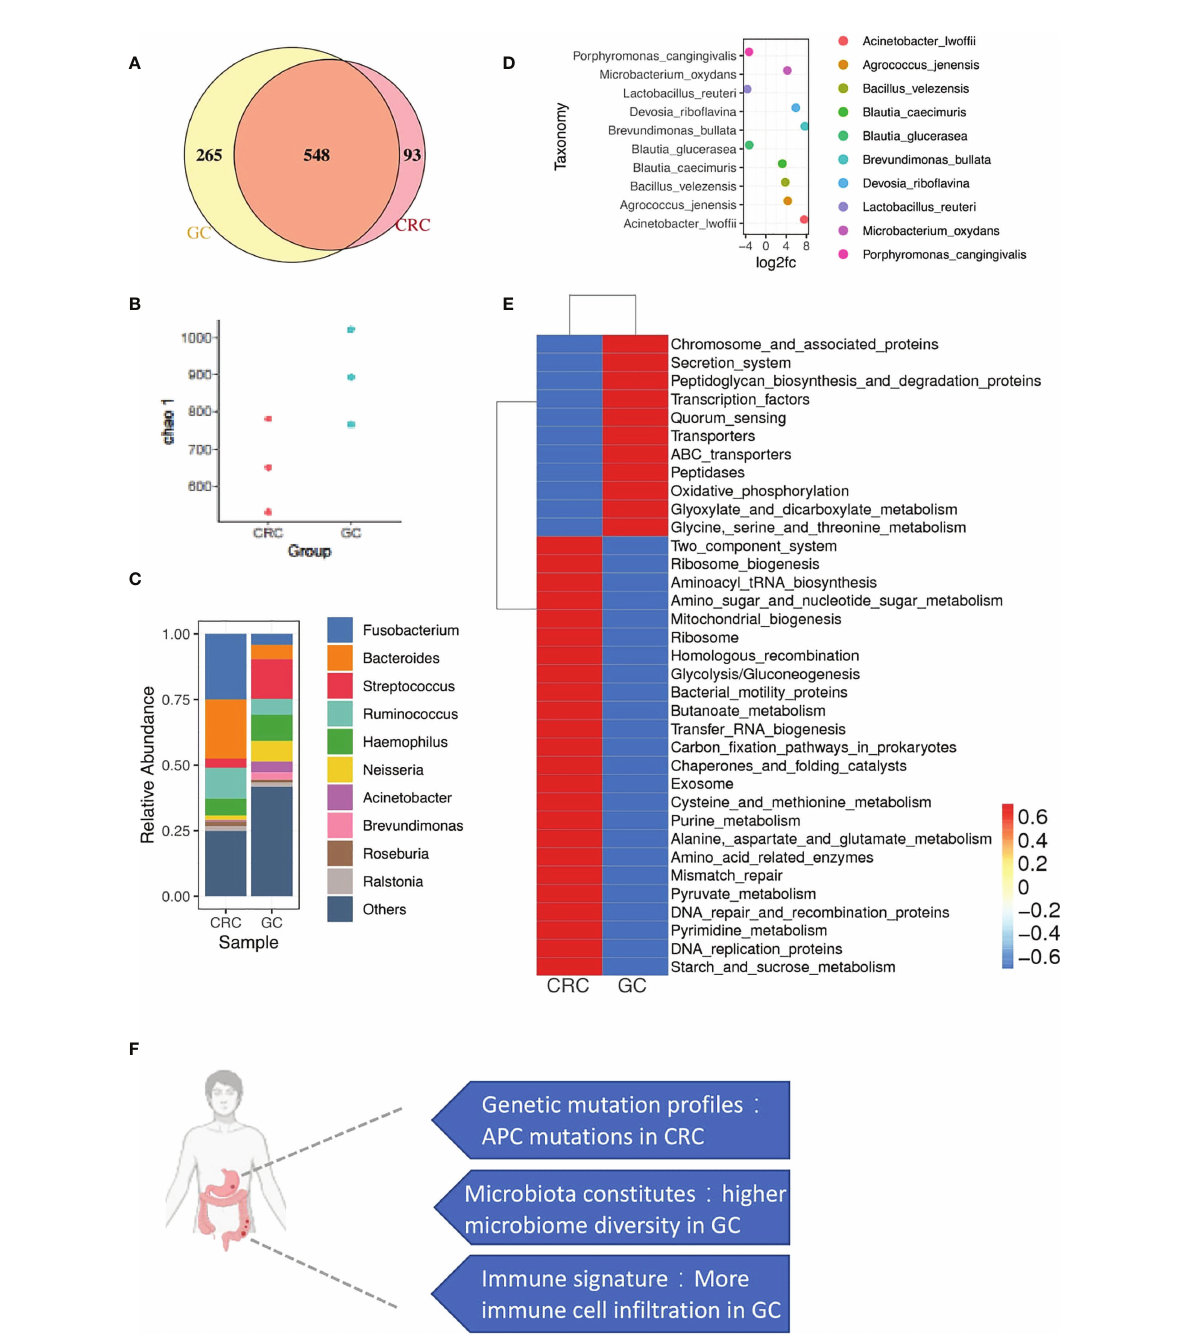
FIGURE 6 microbial pro fi les of CRC and GC. (A) Venn diagram shows the overlap of microbiotas from CRC and GC. Five hundred forty-eight microbiotas were shared between GC and CRC. Two hundred sixty- fi ve microbiotas unique to GC, 93 microbiotas unique to CRC. (B) Plot shows the chao 1 alpha diversity index distribution between CRC and GC groups. (C) Bar plot shows the relative abundance of the top 10 microbiotas in CRC and GC at the genus level. (D) Dot plot shows the top 10 differentially abundant OTUs between CRC and GC at the species level. (E) Heatmap shows the function enrichment pathway of microbiotas in CRC and GC. (F) A brief summary of major differences between CRC and GC in synchronous cancer